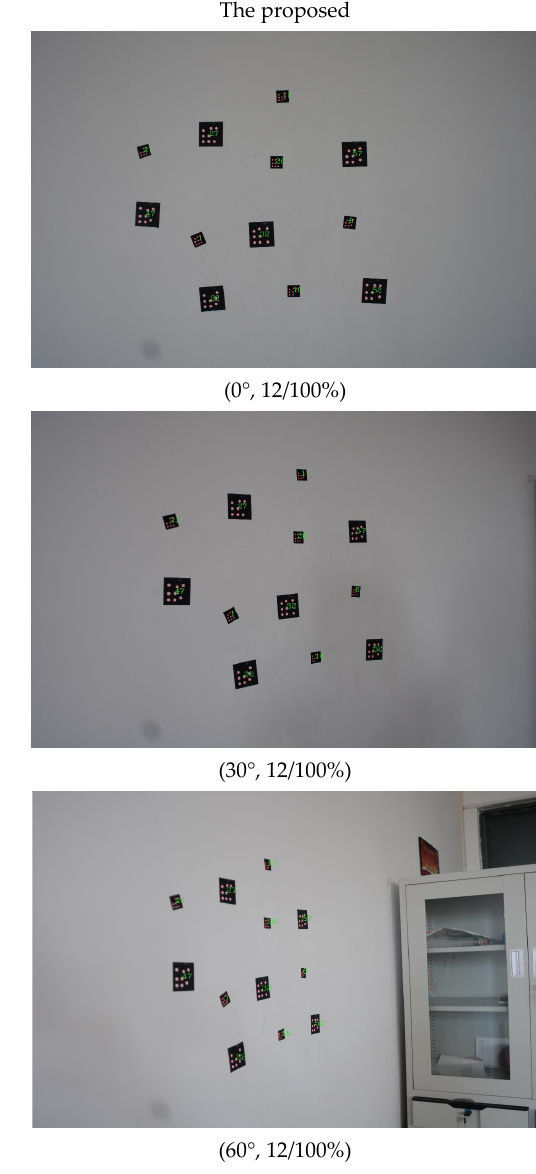
Figure 8. Identification results of mixed GCTs with 3 mm and 6 mm.